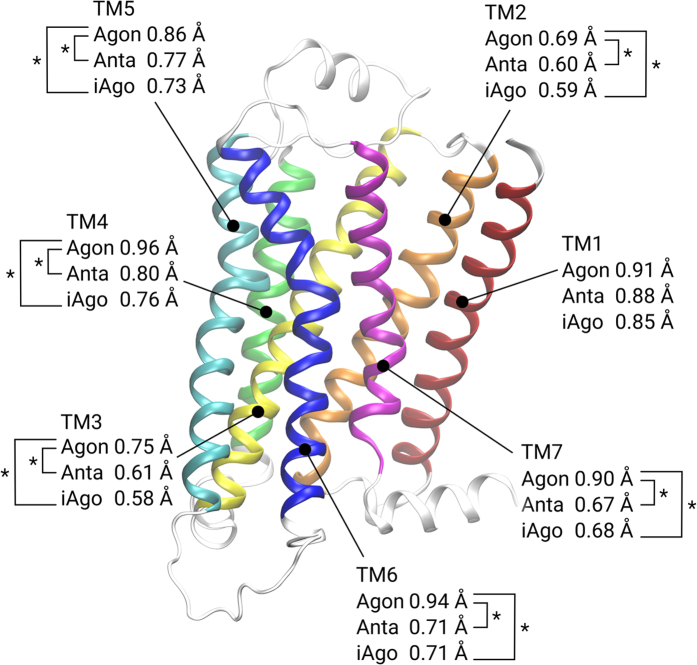
The average root-mean-square-fluctuations (RMSFs) of the protein backbone in each helix, in the presence of agonists (Agon), antagonists (Anta) or inverse agonists (iAgo).(red) TM1: W321.31 to K601.59. (orange) TM2: V672.38 to M962.67. (yellow) TM3: N1033.22 to T1363.55. (green) TM4: A1504.42 to M1714.63. (cyan) TM5: Q1975.36 to K2275.66. (blue) TM6: H2696.31 to I2986.60. (magenta) TM7: K3057.32 to R3287.55. An asterisk indicates a significant difference between the two values at p < 0.01, using a two-tailed t-test with equal variances.